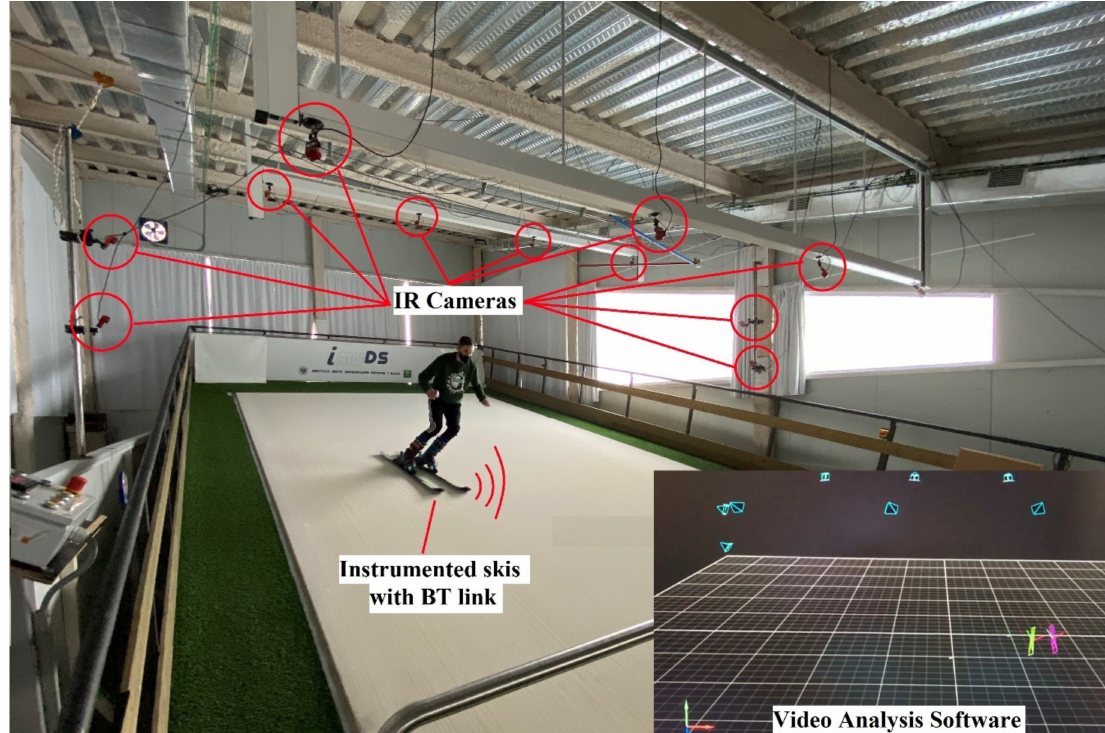
Figure 1. A skier during an experimental test in the ski simulator located at the Sport and Health University Research Institute (iMUDS), University of Granada, Granada, Spain. Infrared (IR) cameras, instrumented skis with Bluetooth (BT) link, and a screenshot of the video analysis software are